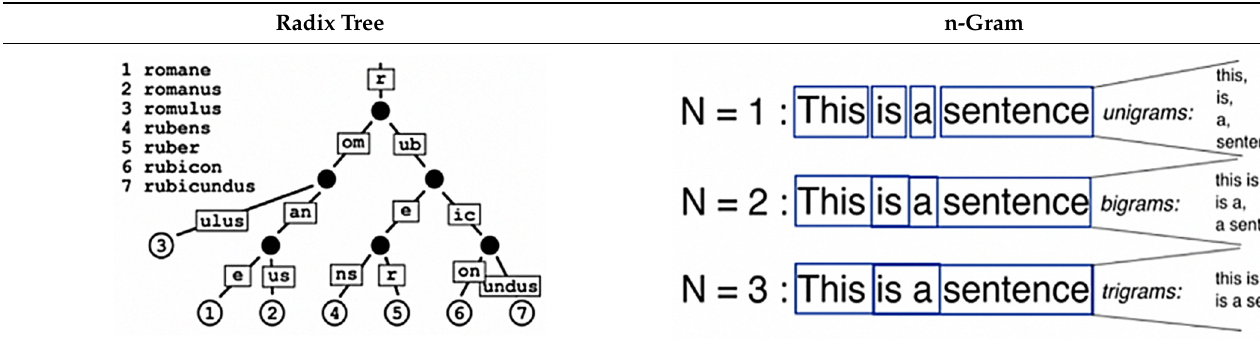
Table 4. The n-gram parsing algorithm.